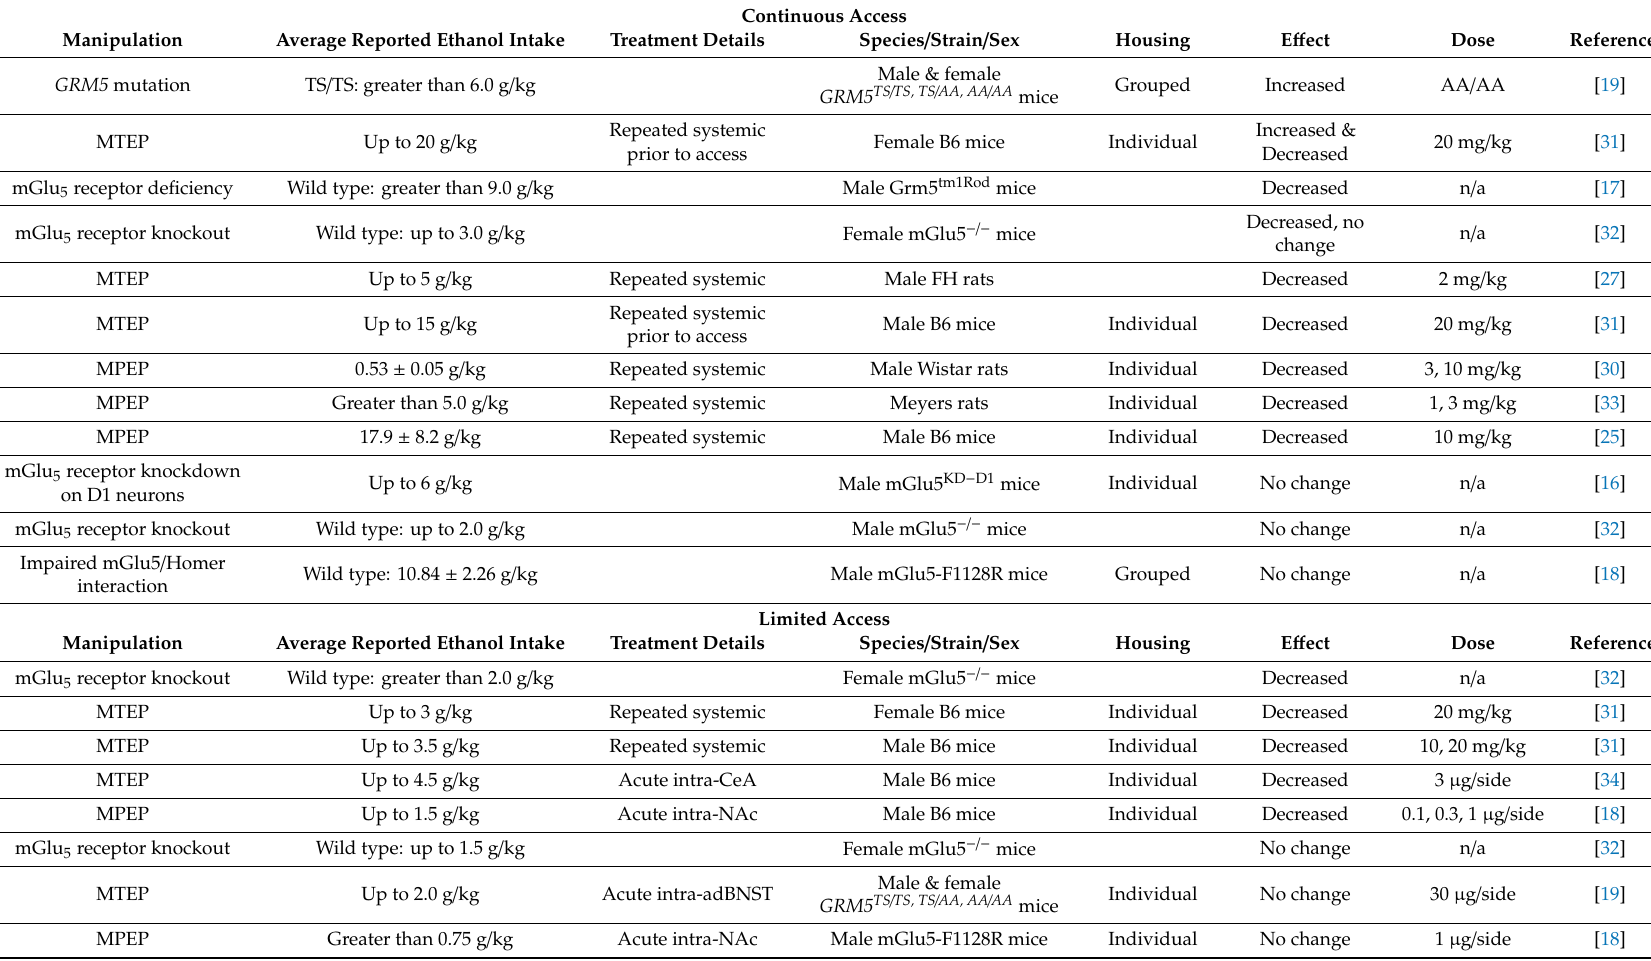
Table 1. Details from studies on the e ff ects of mGlu5 receptor modulation on ethanol intake in continuous access, limited access, and operant ethanol drinking